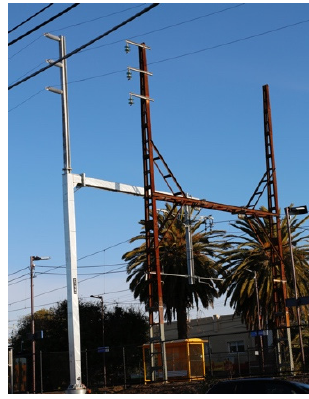
Figure 7. Construction of a new OWS next to a decommissioned one.